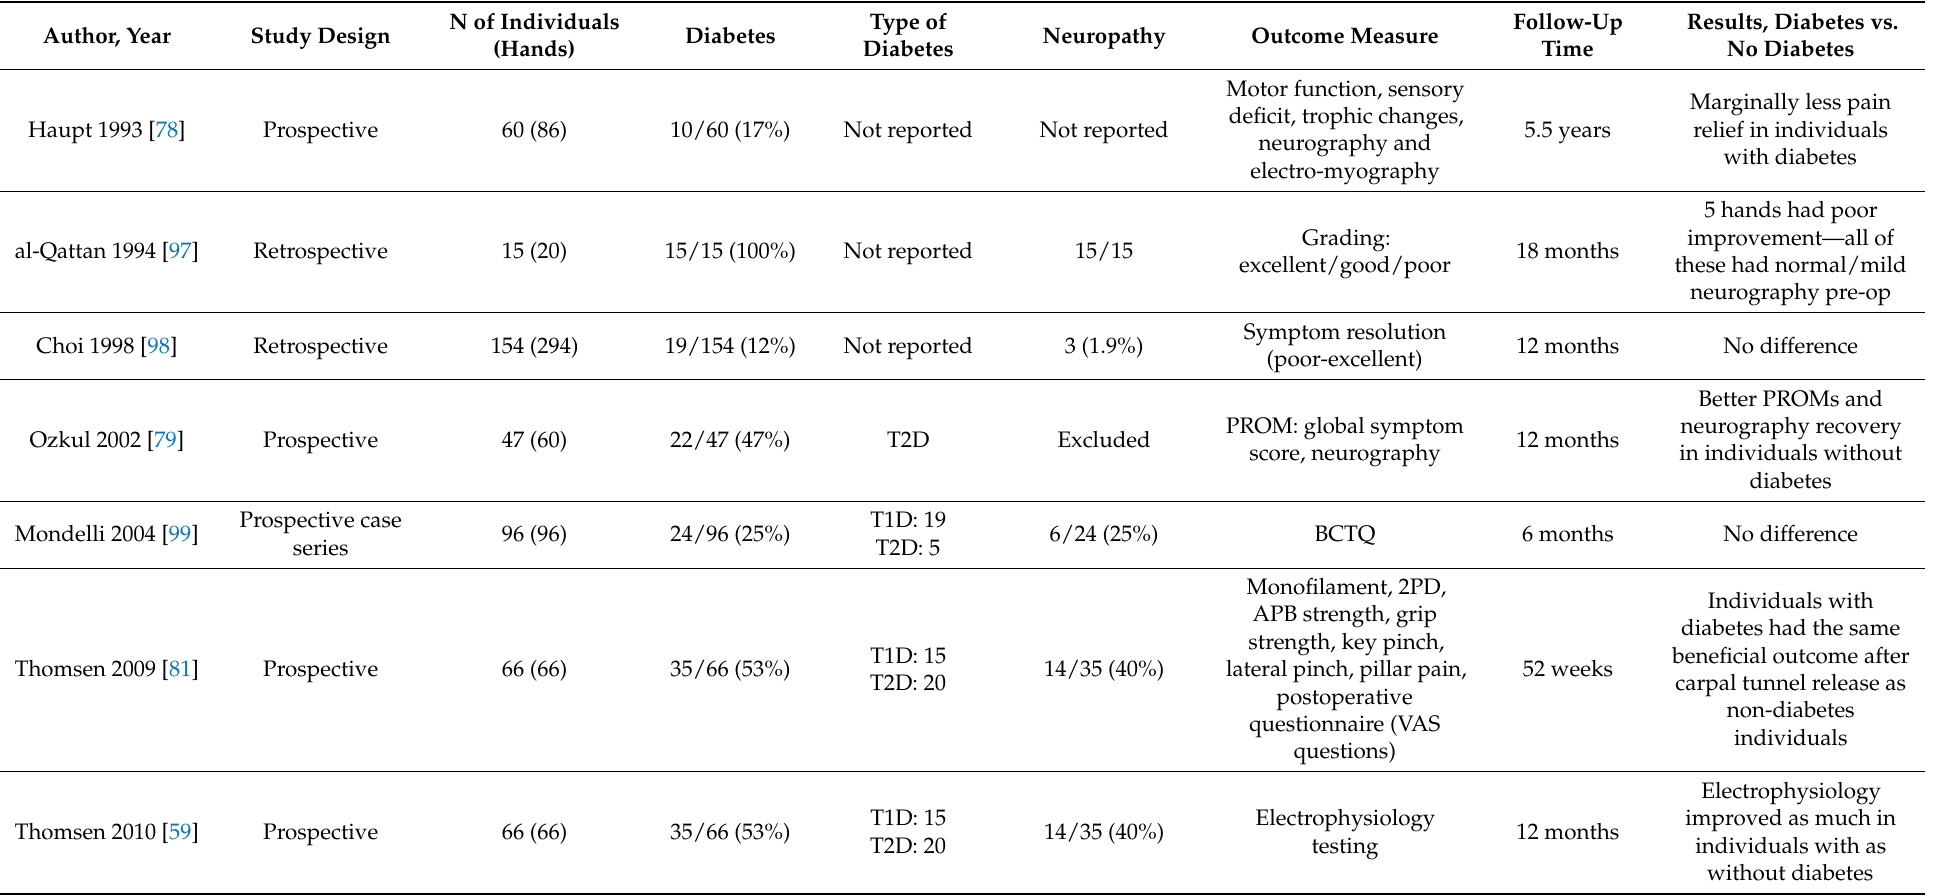
Table 2. Overview of studies evaluating outcome after open carpal tunnel release in individuals’ CTS and with and without